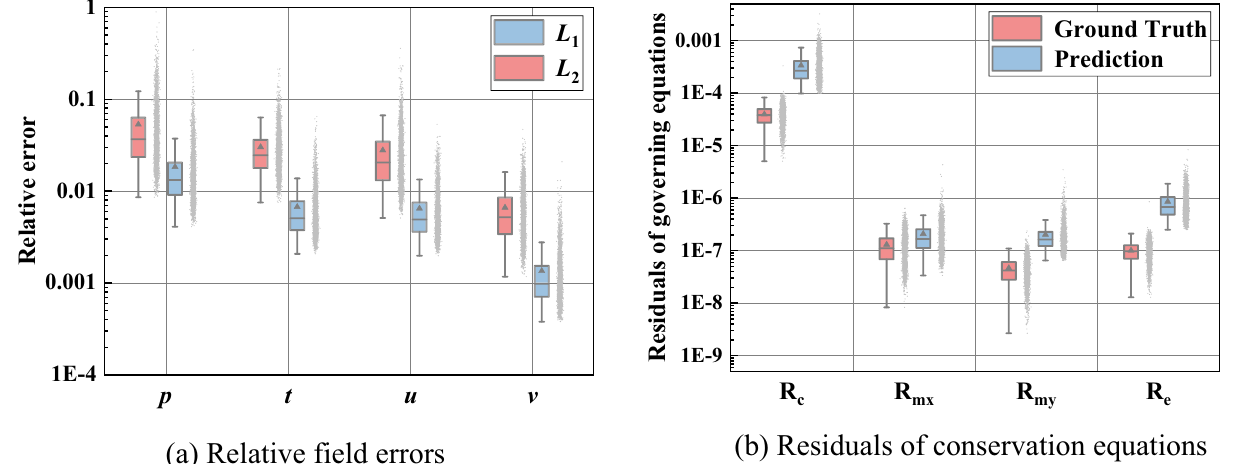
Figure 6. Prediction performance of relative field error and conservation equations.